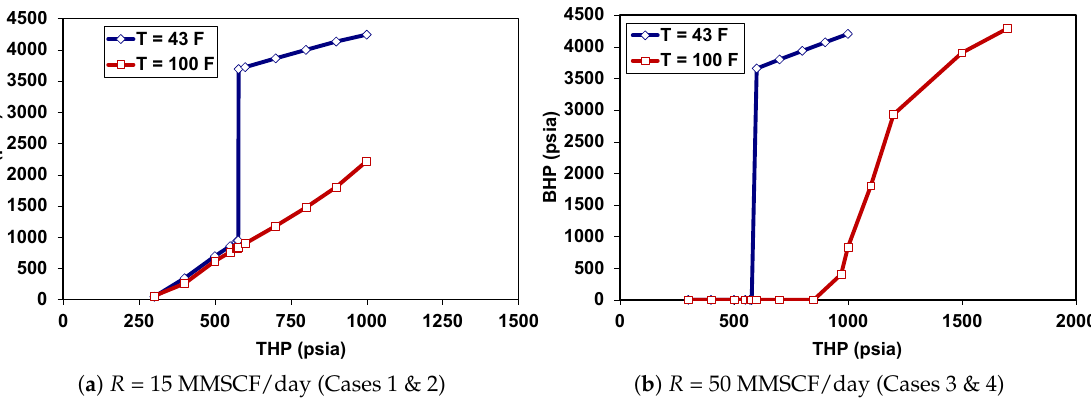
Figure 8. BHP versus THP plots under dynamic conditions with two cases for CO 2 injection, R = 15 MMSCF/day (left, a ) and R = 50 MMSCF/day (right, b ) and two cases for the injected CO 2 fluid temperature at the wellhead, T = 43 ◦ F and T = 100 ◦ F. A pressure jump appears in BHP when CO 2 is injected in its liquid state ( T = 43 ◦ F), whereas BHP is smooth when CO 2 is injected in its supercritical state ( T = 100 ◦